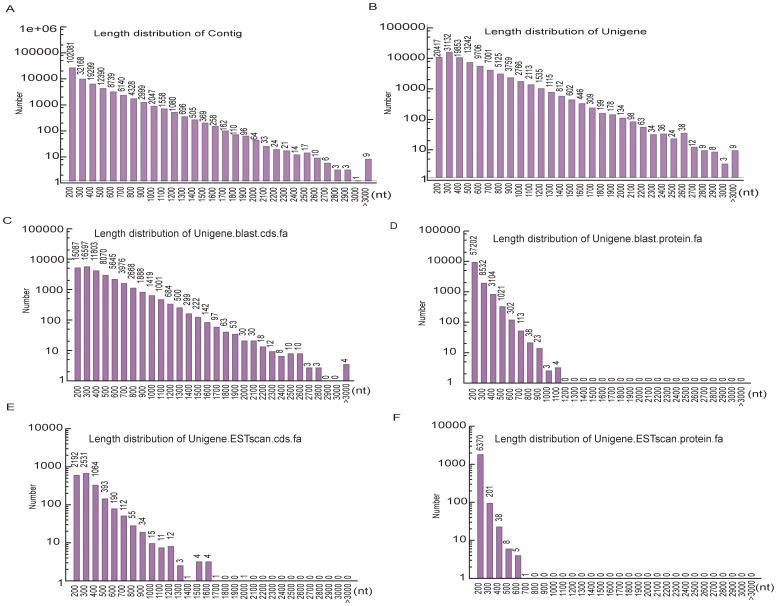
Overview of the safflower flower tissue transcriptome assembly.(A) The size distribution of the contigs obtained from our de novo assembly of high-quality clean reads. (B) The size distribution of the unigenes produced from further assembly of contigs (i.e., contig joining, gap filling, and scaffold clustering). (C) The size distribution of the CDS produced by searching unigene sequences against various protein databases (Nr, SwissProt, KEGG and COG, in order) using BLASTX (E-value <10−5). (D) The size distribution of the proteins predicted from the CDS sequences. (E) And (F) Size distributions of the ESTs and proteins obtained from the ESTScan results. For unigene CDS that had no hits in the databases (Nr, SwissProt, KEGG and COG), the BLAST results were subjected to ESTScans and then translated into peptide sequences.